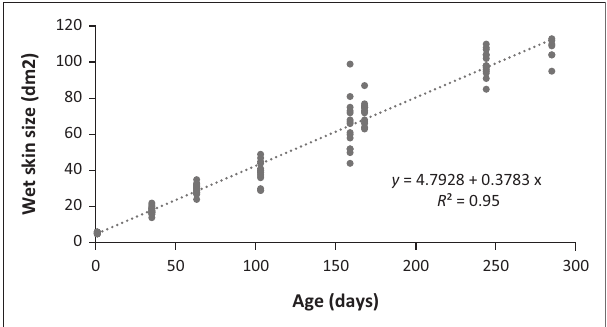
FIGURE 2: Illustration of the relationship between skin size (dm2) and age (days) in ostriches.